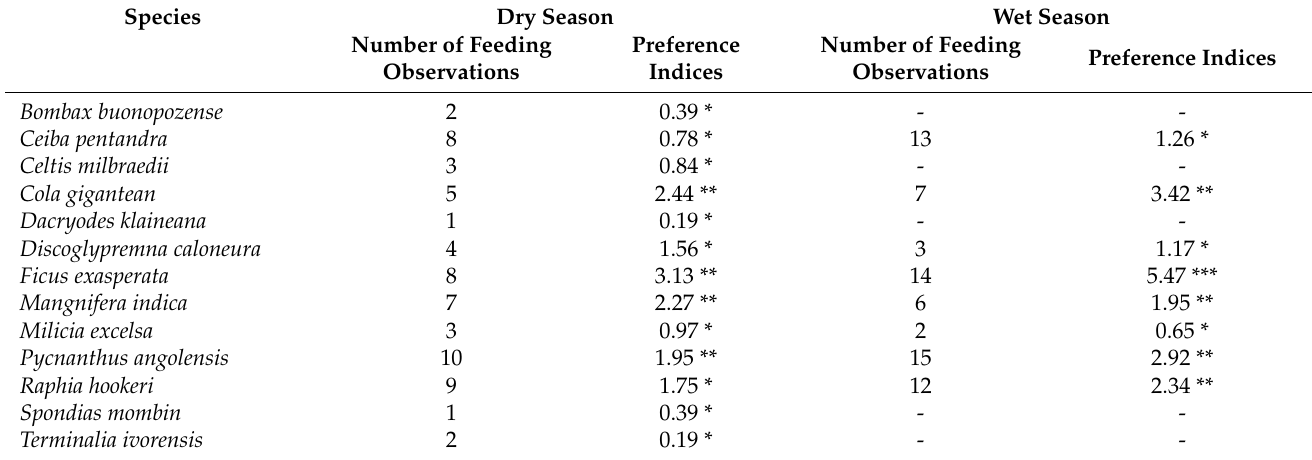
Table 1. Preference indices of plant species consumed by Lowe’s monkeys in the Duasidan Monkey Sanctuary, Ghana.